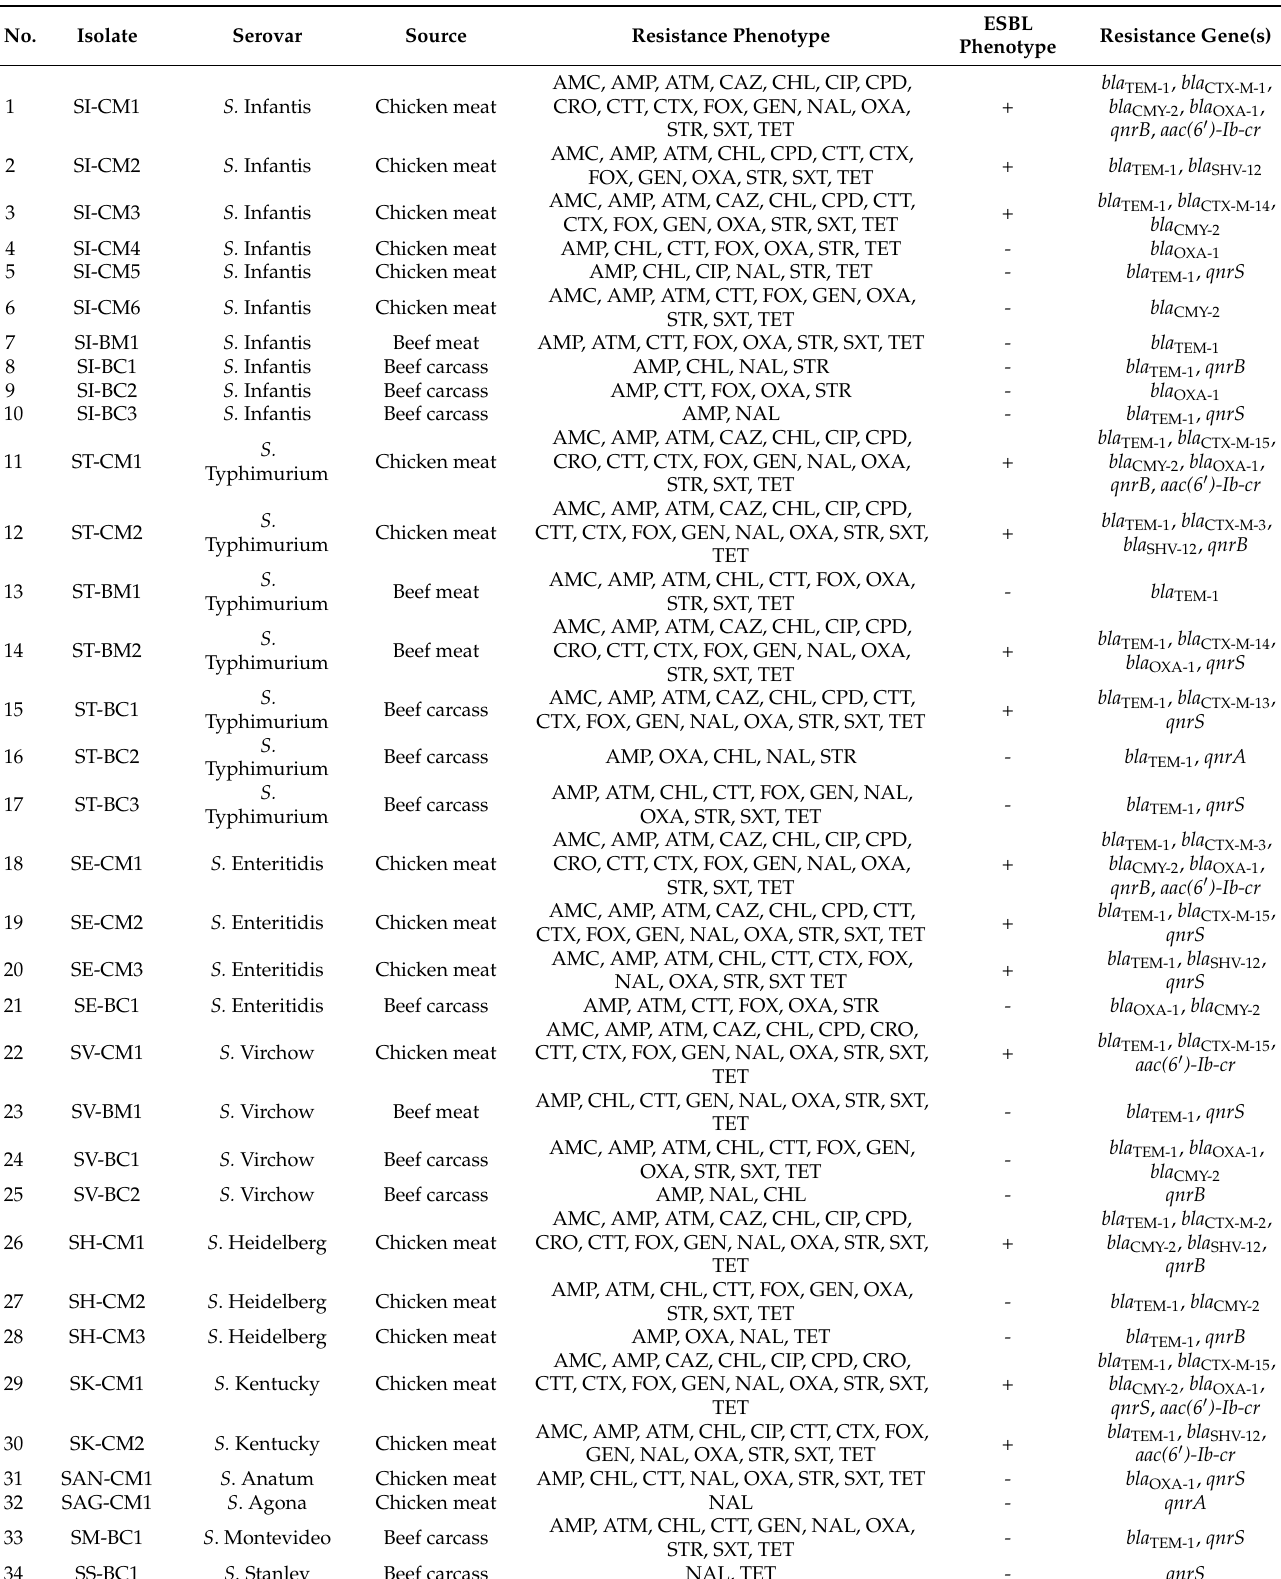
Table 1. Resistance phenotypes and incidence of resistance genes in Salmonella enterica isolated from retail meats and beef carcasses in